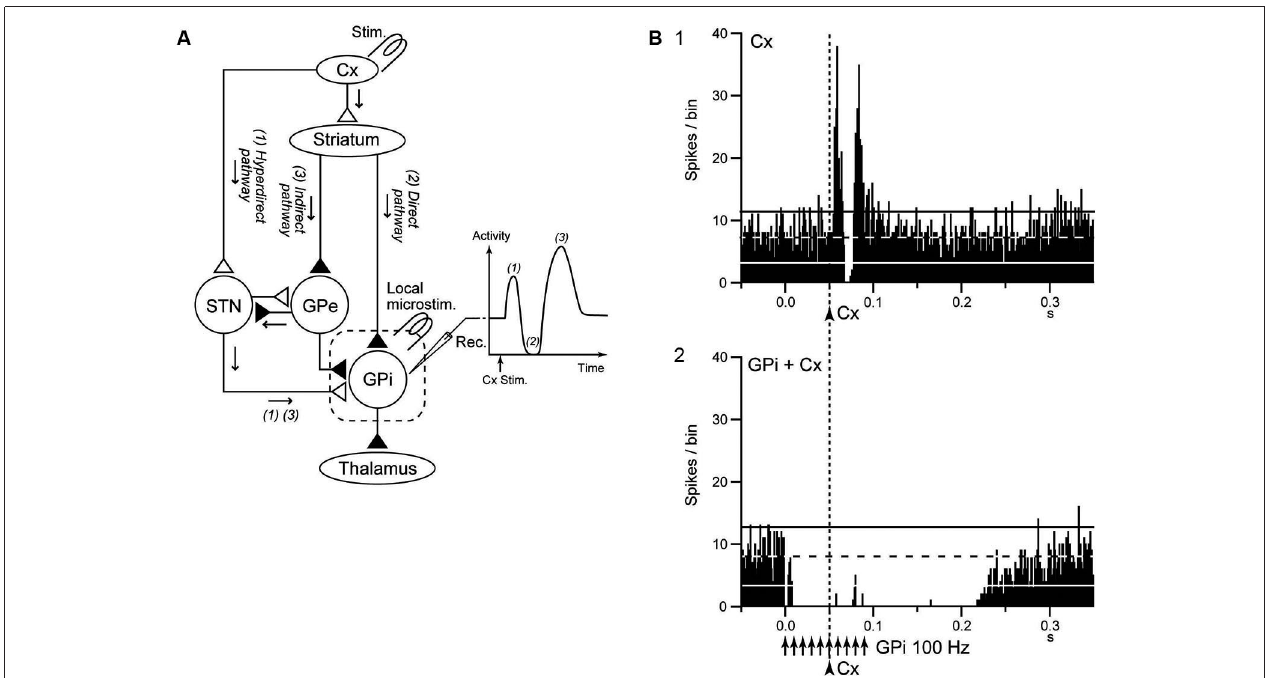
respectively. (B) Effects of local GPi-HFS on cortically evoked responses of a GPi neuron in a normal monkey. PSTH (100 trials) in response to the single pulse stimulation (arrowhead with dotted line) of the primary motor cortex (Cx) (1) and PSTH in response to Cx stimulation (arrowhead with dotted line) during GPi-HFS (arrows) (2) are shown. Cortical stimulation was applied 50 ms after the initiation of GPi-HFS. The cortically evoked responses were entirely inhibited during GPi-HFS. Modified from Chiken and Nambu